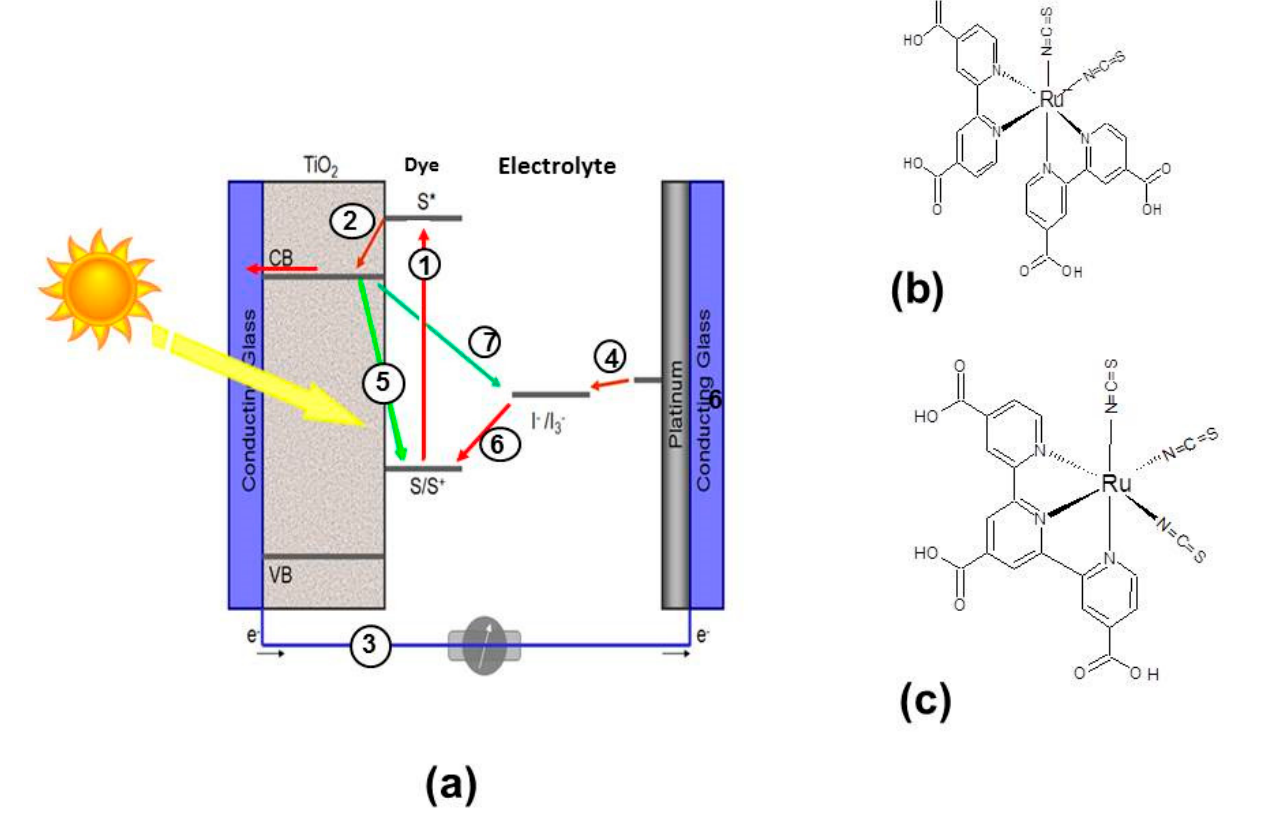
Figure 1. ( a ) Schematic representation of a DSSC device; ( b ) N3 dye; ( c ) BD dye.